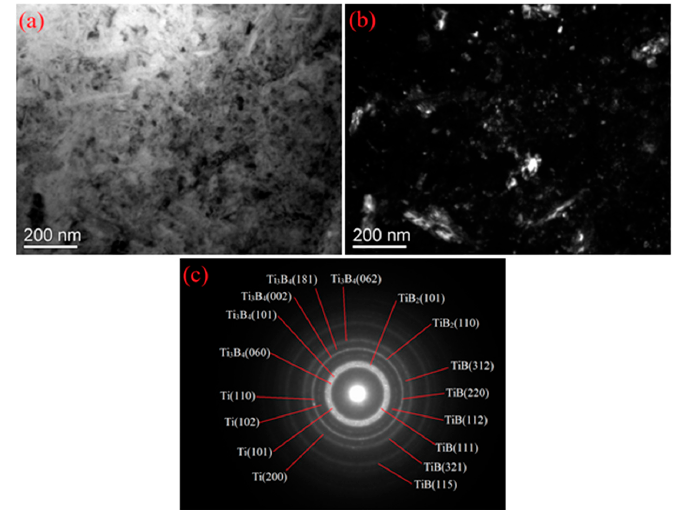
Figure 6. TEM images and corresponding SAED patterns of the borided layer of the 120 min SMAT sample: ( a ) light field; ( b ) dark field; ( c ) electron diffraction patterns.